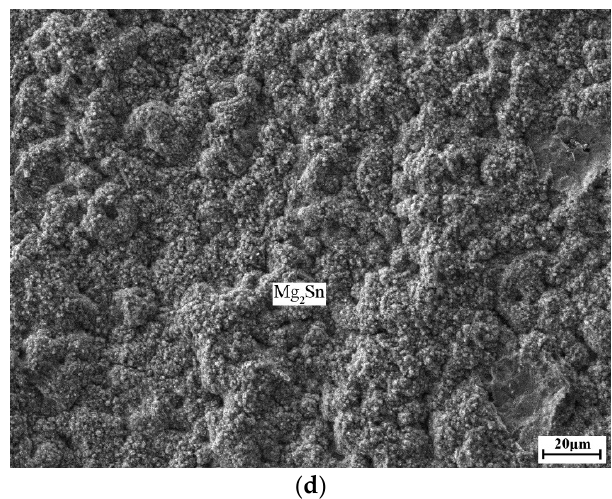
Figure 15. Fractographs of the AZ31 magnesium alloy/6061 aluminum alloy joints bonded with the Sn-20Zn-0.1RE filler metal after aging at 150 °C. ( a ) the 6061 aluminum alloy side after 50 h of aging; ( b ) the AZ31 magnesium alloy side after 50 h of aging; ( c ) the 6061 aluminum alloy side after 100 h of aging; ( d ) the AZ31 magnesium alloy side after 100 h of aging.